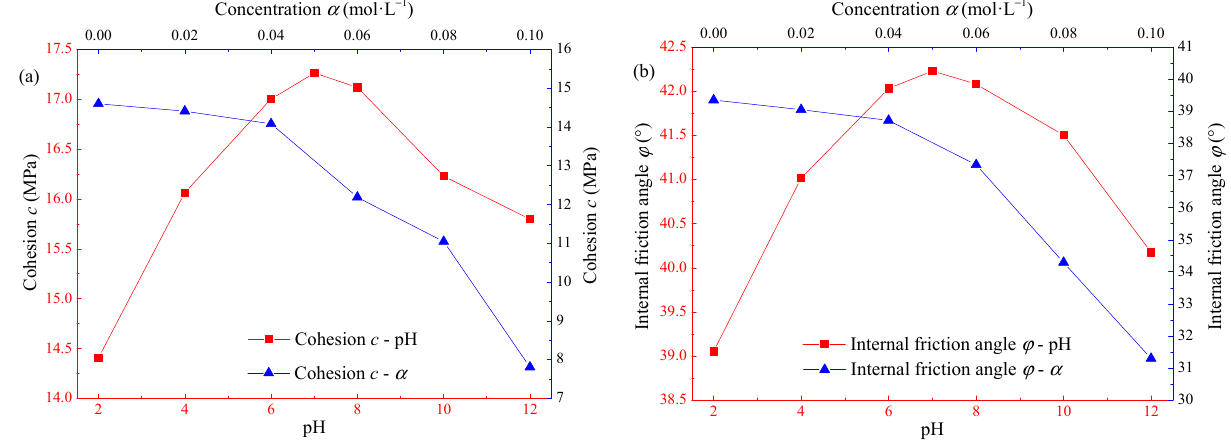
Figure 6. Distribution curve of shear strength parameters of Na 2 SO 4 corroded sandstone: ( a ) cohesion c ; ( b ) internal friction angle φ .